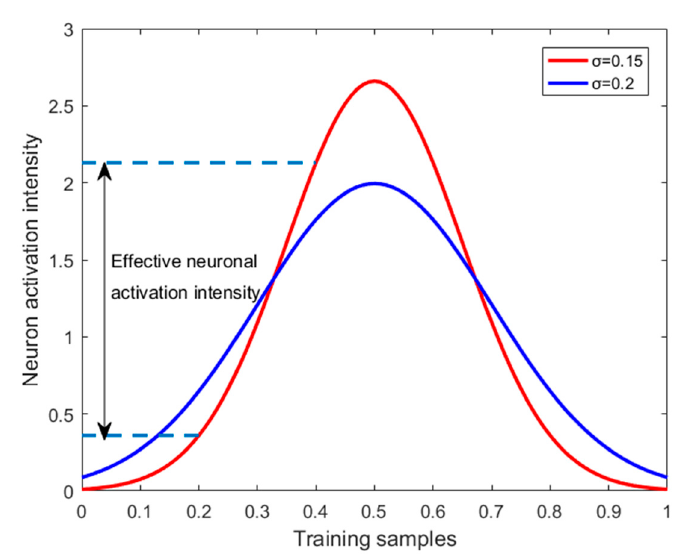
Figure 2. Neuron activation strength.